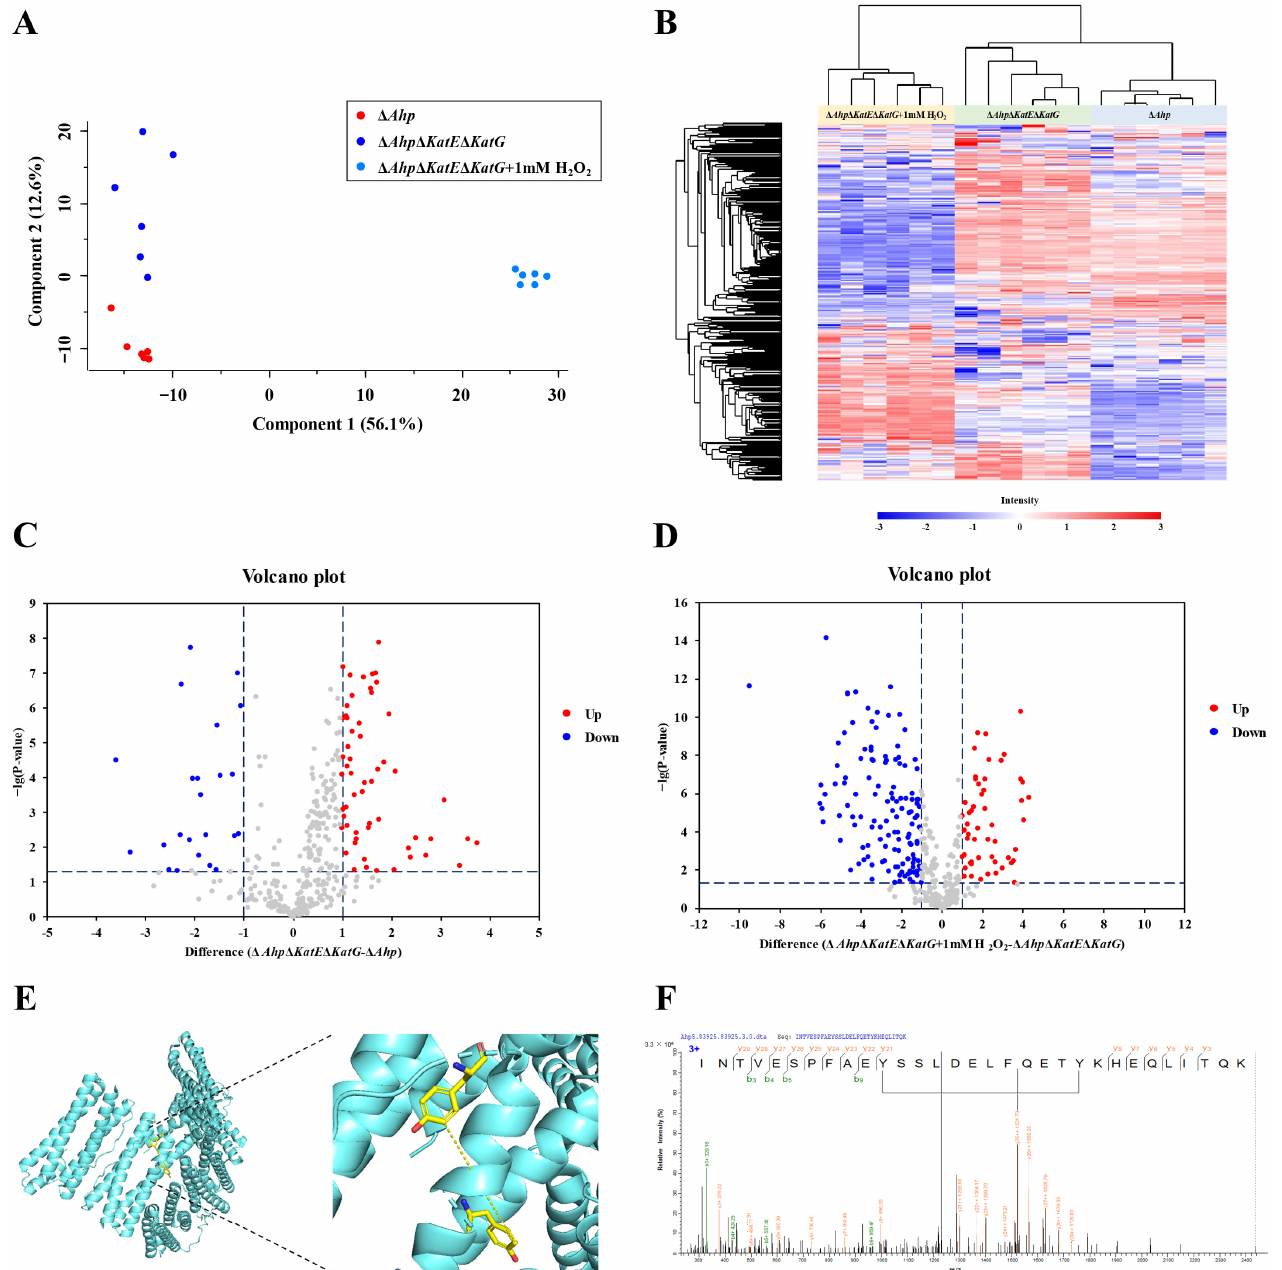
Figure 3. Quantification of dityrosine-linked peptides. ( A ) Principal component analysis (PCA) of the three groups. Components 1 and 2 are shown. The red dots represent E. coli MG1655/ ∆ Ahp , the blue dots represent E. coli MG1655/ ∆ Ahp ∆ KatE ∆ KatG , and the light blue dots represent E. coli MG1655/ ∆ Ahp ∆ KatE ∆ KatG supplemented with 1 mM H 2 O 2 . ( B ) Heatmap of the three groups, show- ing the differences among each group, which suggested a reliable quantification result. ( C ) Volcano plot for E. coli MG1655/ ∆ Ahp ∆ KatE ∆ KatG and E. coli MG1655/ ∆ Ahp . ( D ) Volcano plot for E. coli MG1655/ ∆ Ahp ∆ KatE ∆ KatG supplemented with 1 mM H 2 O 2 and E. coli MG1655/ ∆ Ahp ∆ KatE ∆ KatG . The red dots and blue dots represent upregulated and downregulated dityrosine-linked peptides, respectively. ( E ) The location of the dityrosine-loop linked peptide is shown in yellow in the bacterial non-heme ferritin spatial structure. The 3D graph was generated from the PyMol Molecular Graphics System, and the PDB file (accession codes:1EUM) was downloaded from the RCSB website. ( F ) The MS/MS spectrum of the dityrosine-loop linked peptides in bacterial non-heme